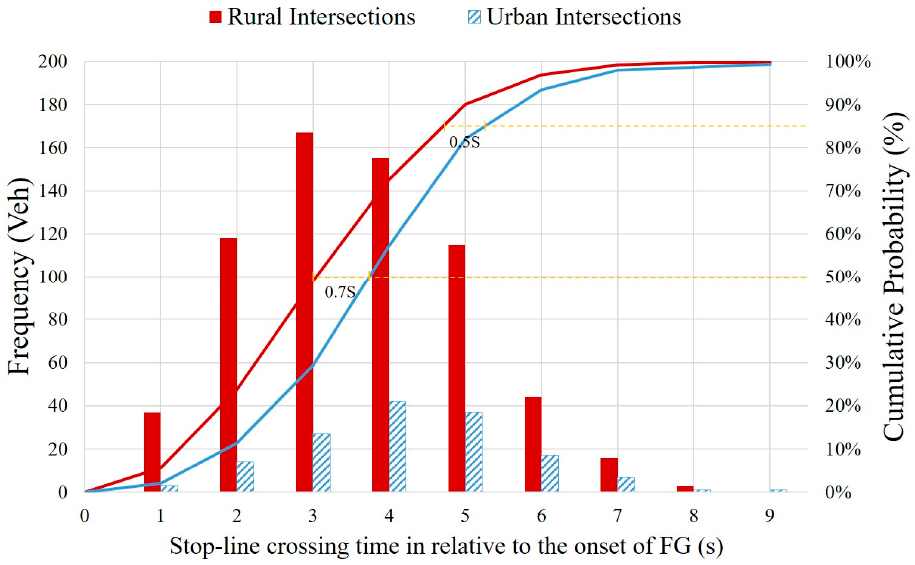
Figure 3. Observed frequencies and cumulative probability of stop-line crossing time.